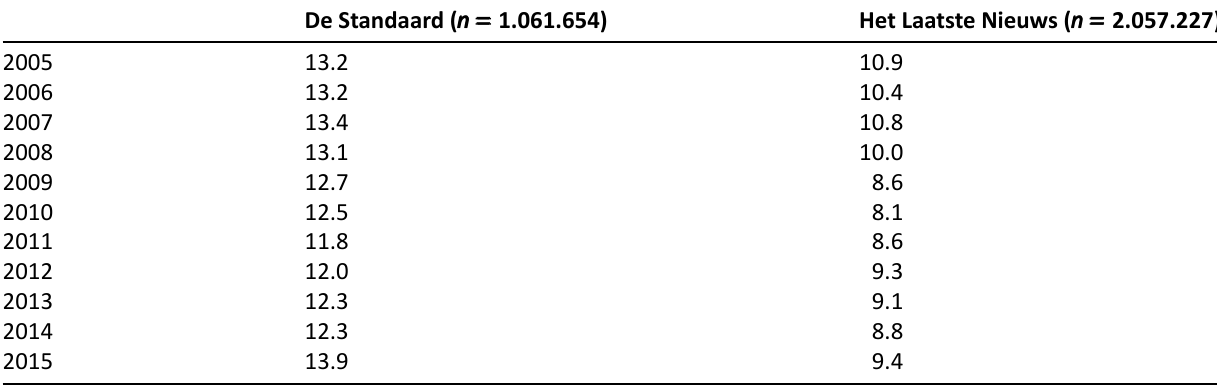
Table 1. The percentage of female actors with respect to the total number of actors by whom gender was assigned between 2005 and 2015 both in the quality paper De Standaard and the popular paper Het Laatste Nieuws . De Standaard ( nnn ===